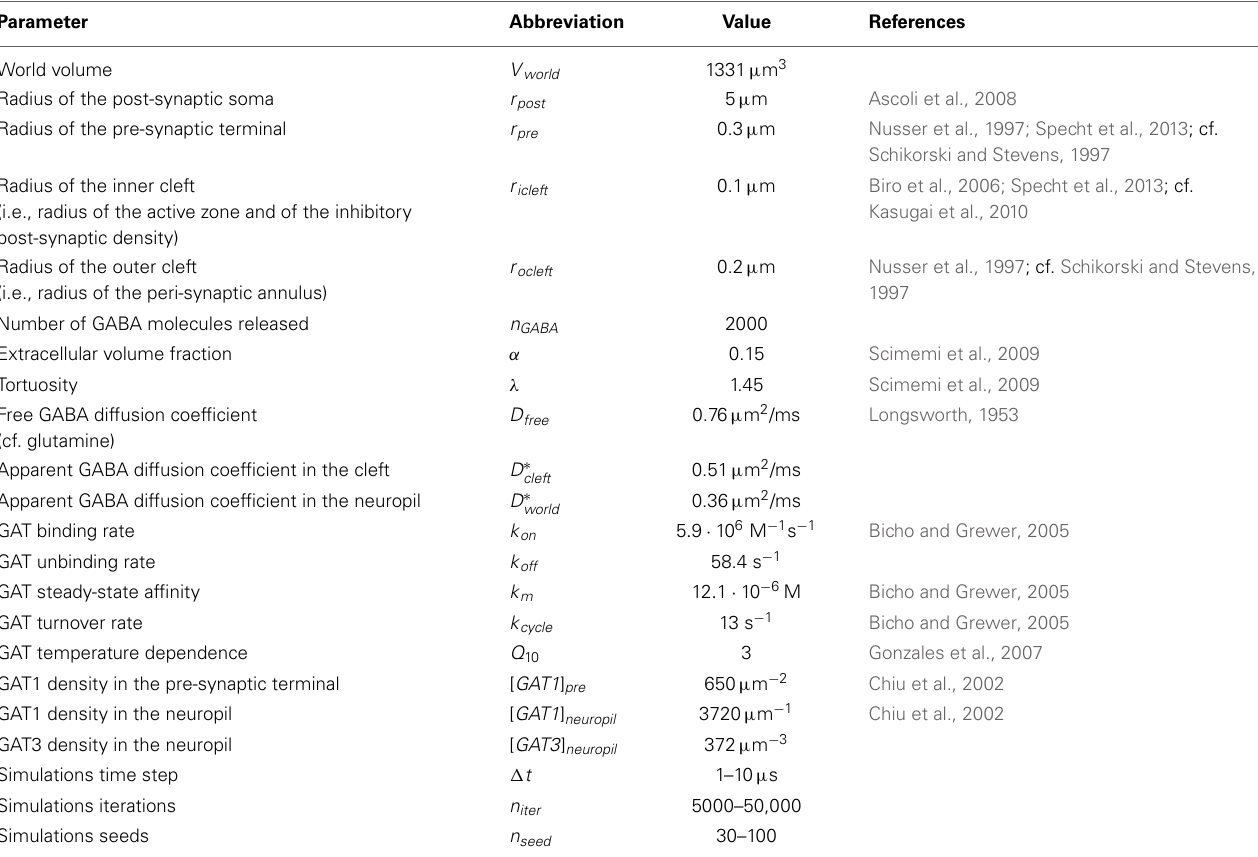
Table 1 | Parameters used for the 3D Monte Carlo reaction-diffusion